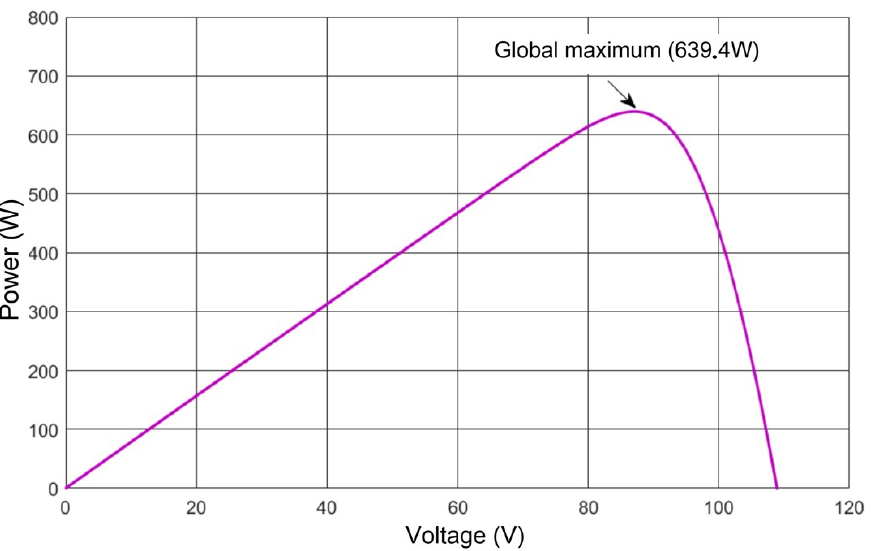
Figure 9. P-V characteristic curve of the PV array without shading. Simulation—Step 1